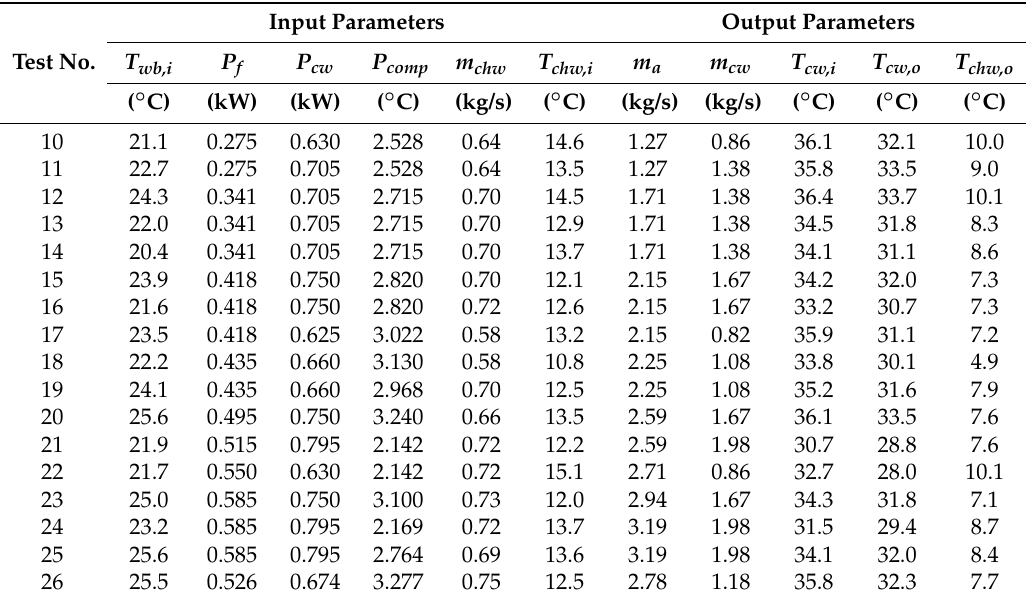
Table 3. Corresponding coefficients of the models and constraint.